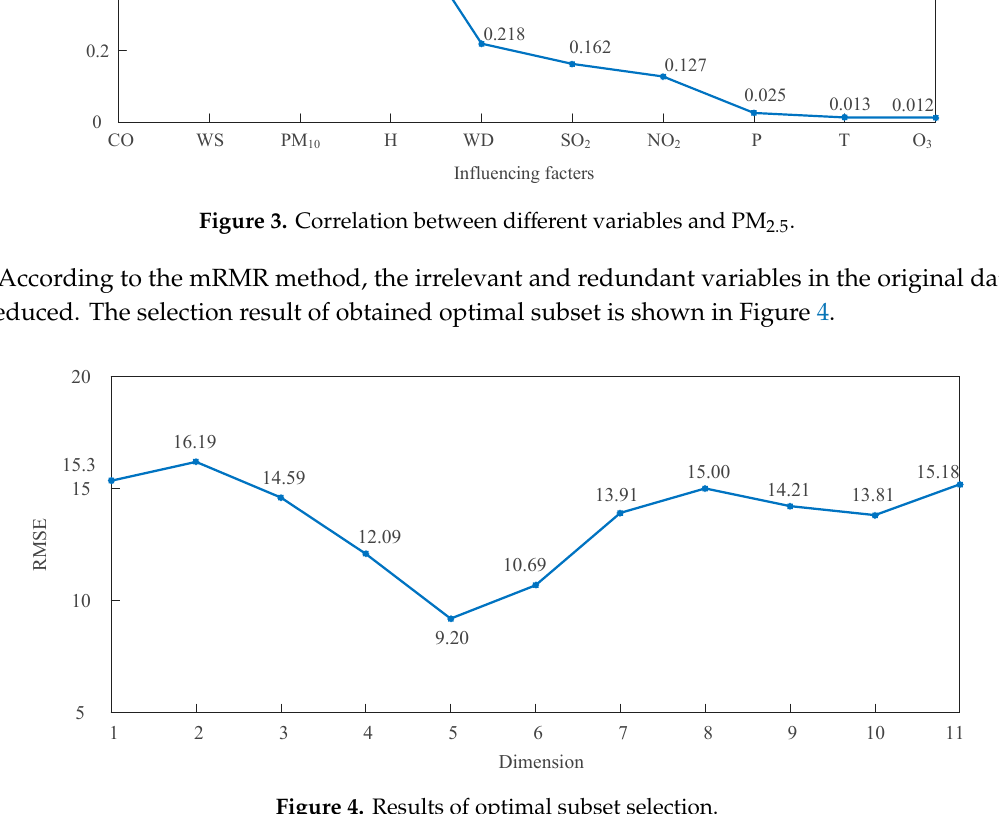
Figure 4. Results of optimal subset selection.